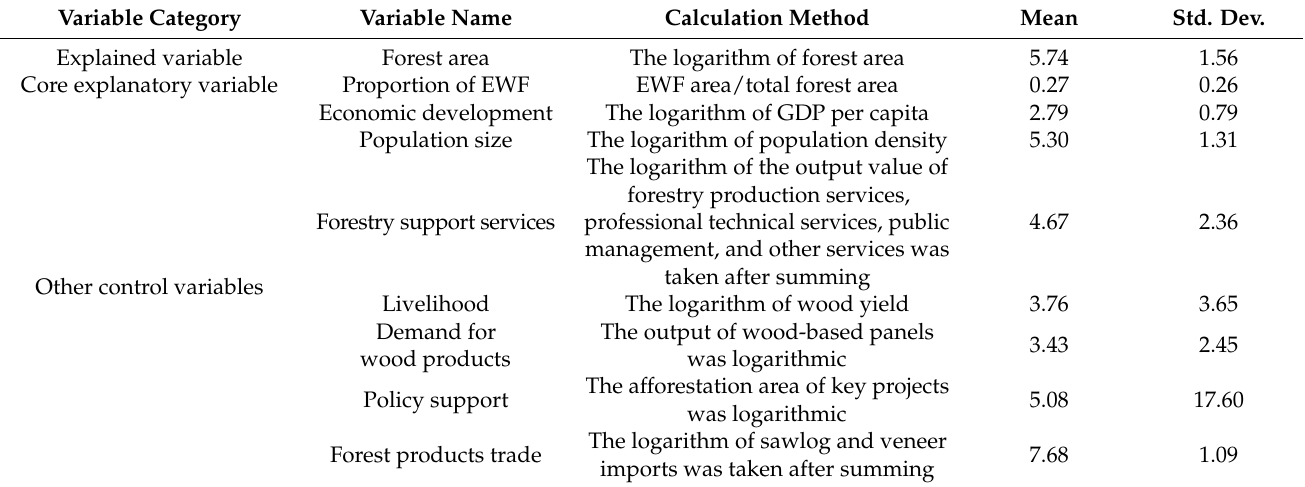
Table 1. Descriptive